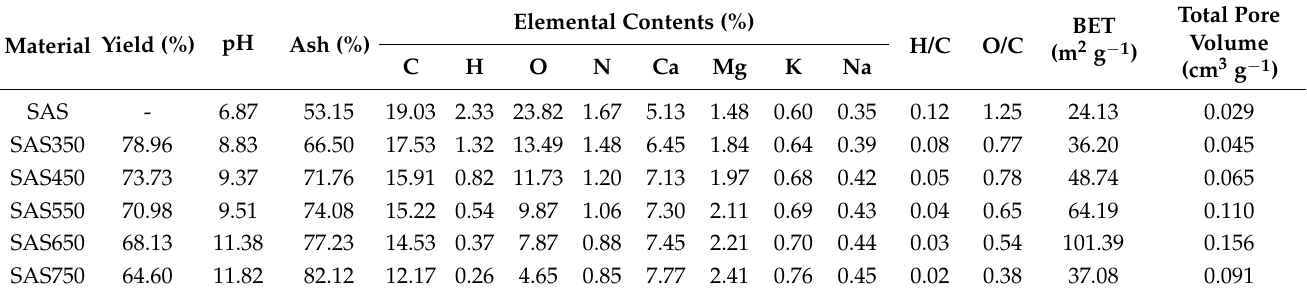
Table 1. Physicochemical properties of biochars at different pyrolysis